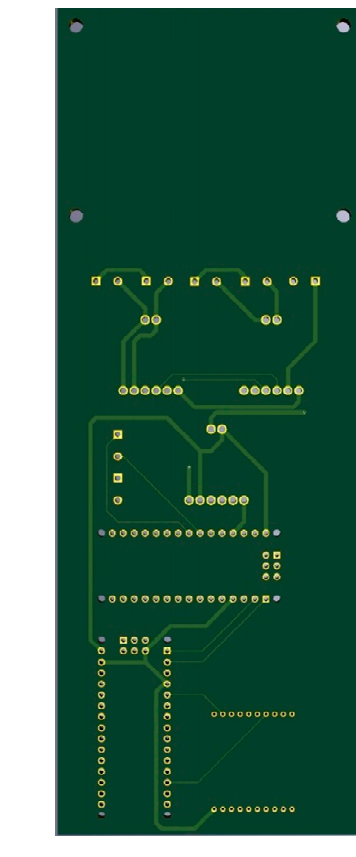
Figure 4. PCB of the THMDL with battery power supply: ( a ) front side and ( b ) back side.